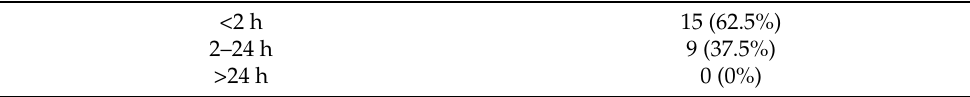
Table 4. The timing of MTP activation after